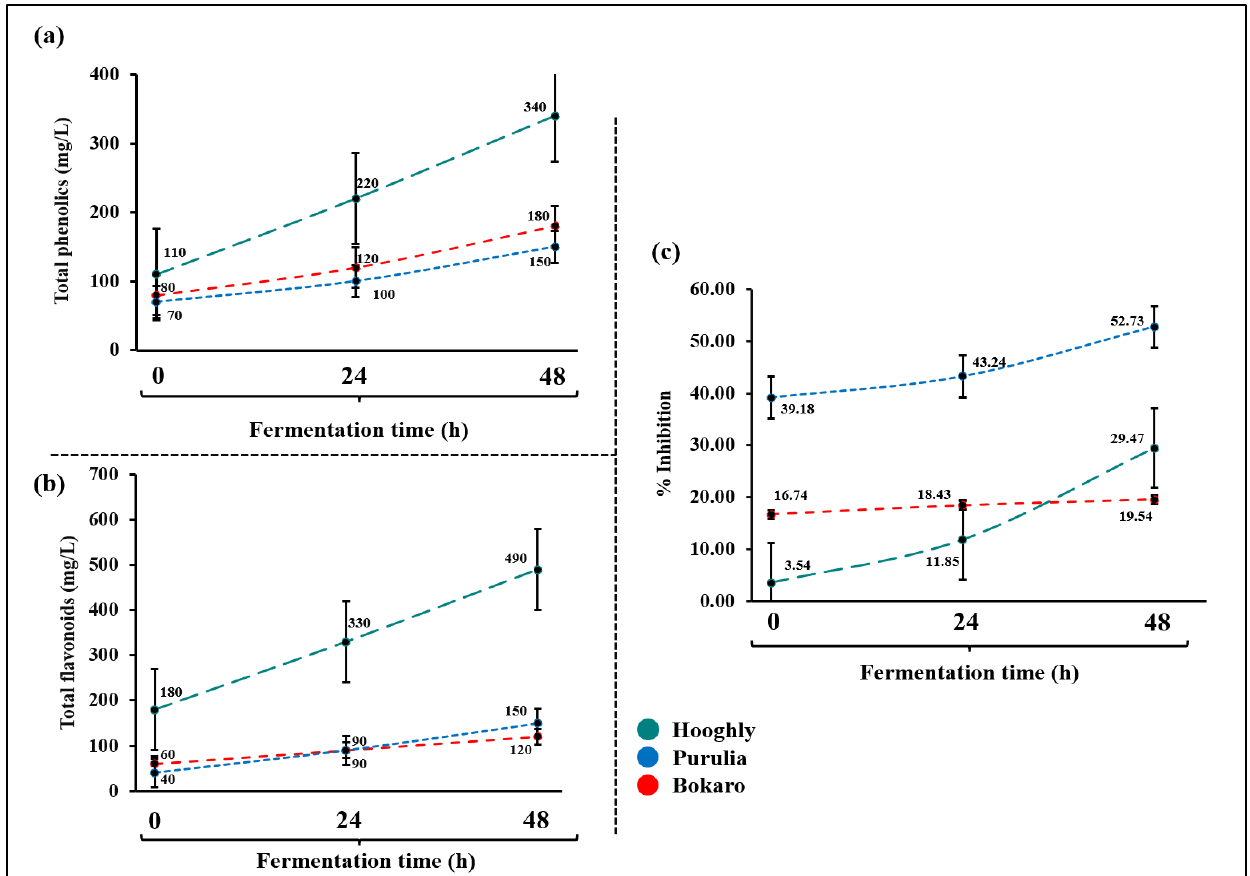
Figure 5. Successional increase in various bio-active and health-promoting attributes of toddy fermentation, viz. ( a ) content of total phenolics, ( b ) total flavonoid content and ( c ) anti-oxidant activity by radical scavenging assay. Table 2. Successional changes in the alcohol content throughout the fermentation of toddy and cor- responding alcoholic proportion distribution between ethanol and methanol.